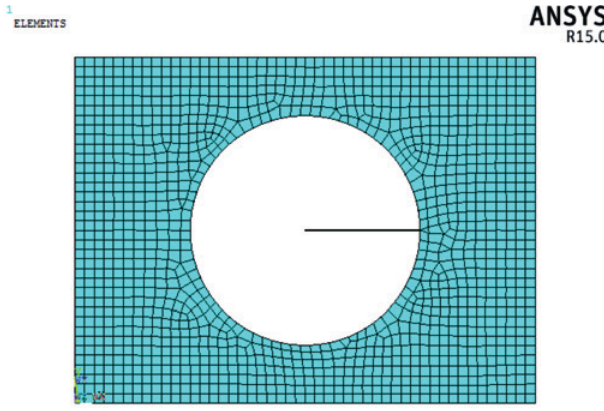
Modelo numérico da placa celular –